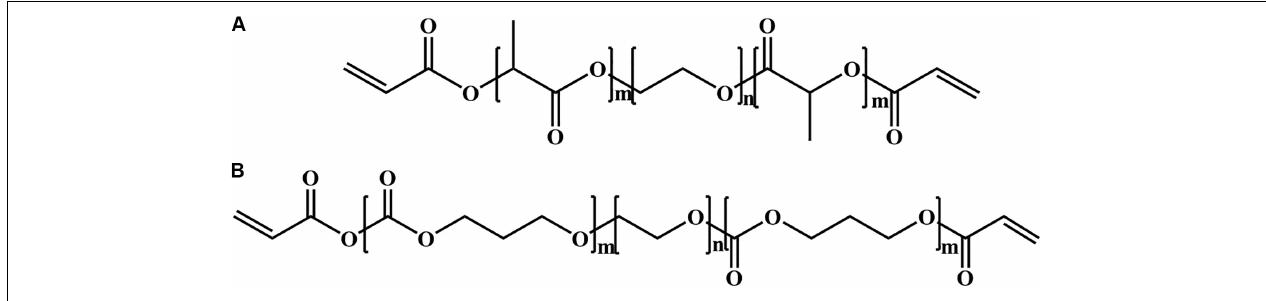
FIGURE 2 | Two different building blocks of photopolymerizable copolymer for PEG photopolymerizable tissue adhesives with (A) PLA-PEG-PLA and (B) PTMC-PEG-PTMC